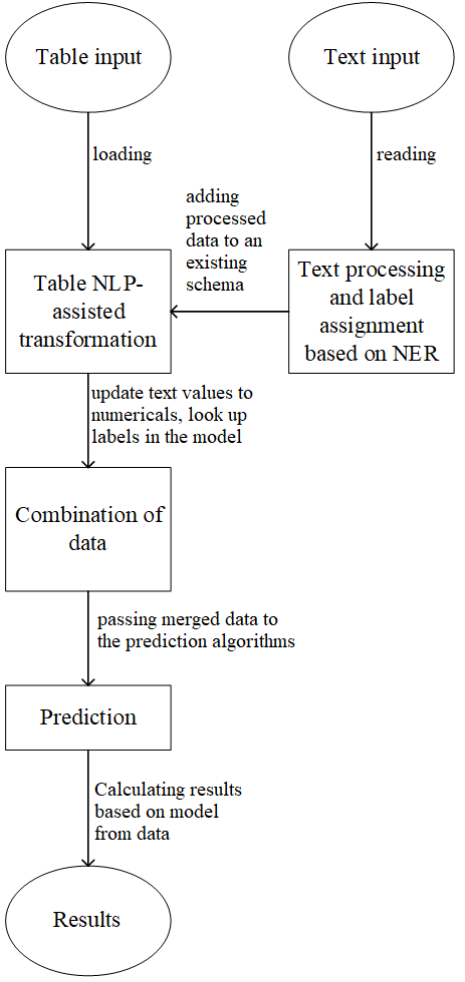
Figure 3. Scheme for an experimental unit conversion